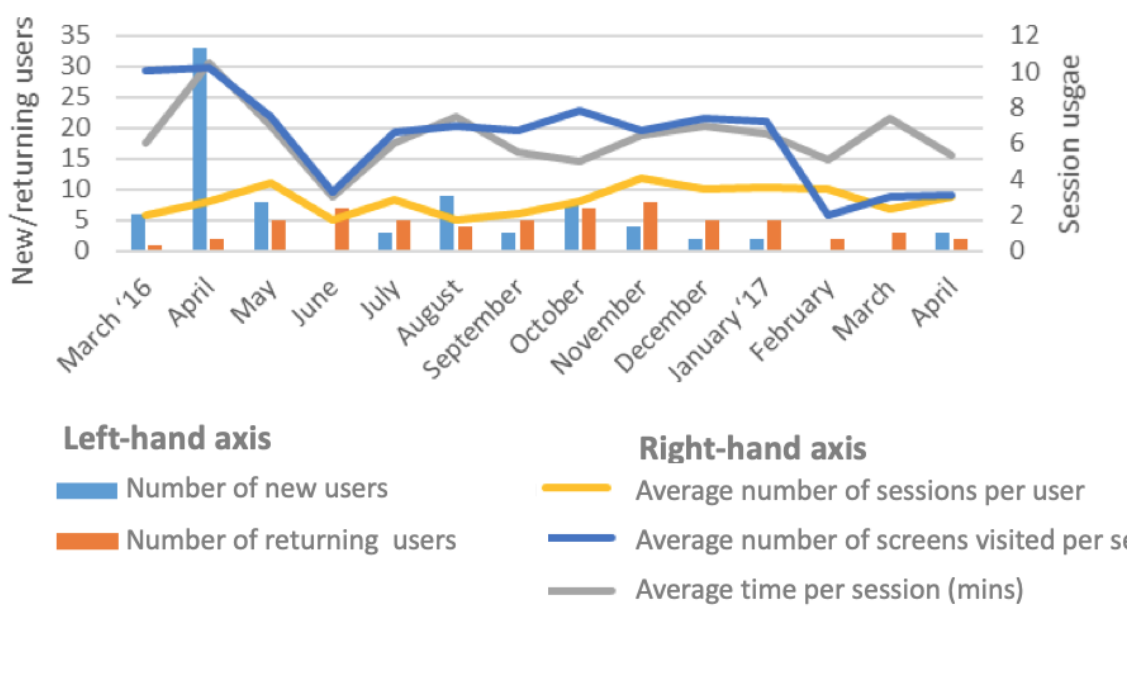
Figure 7. App usage by month (March 2016-April